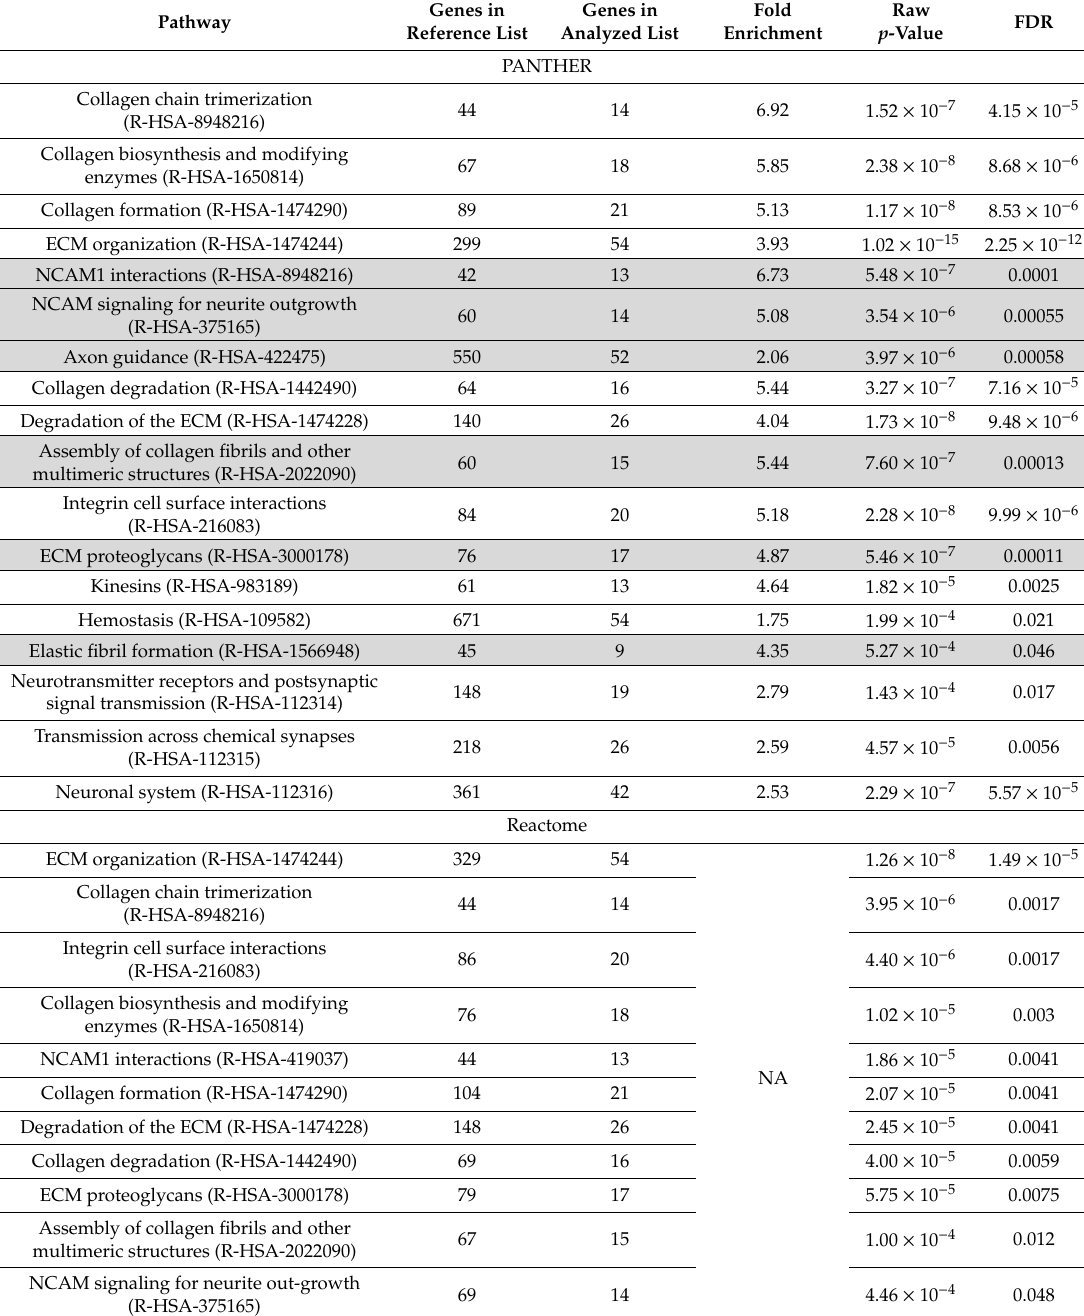
Table 3. Results from pathway analysis in PANTHER and Reactome. Adjacent pathways sharing the same background color are hierarchically related to each other in the PANTHER analysis. Fold-enrichment is not reported by Reactome (NA = not applicable). FDR = false discovery rate; ECM = extracellular matrix; R-HSA-XXX = Reactome pathway